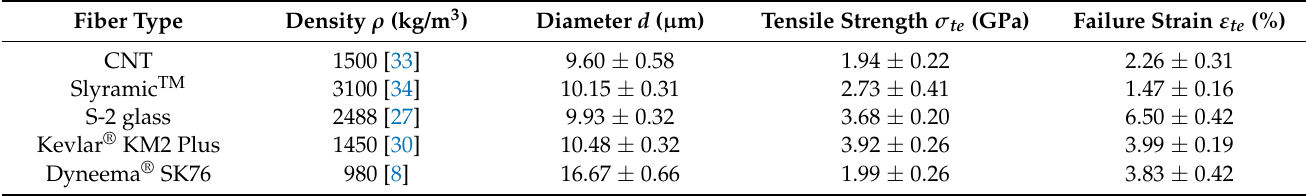
Figure 4. Tensile stress–strain curves of different fibers. Table 1. Material properties of different fibers.